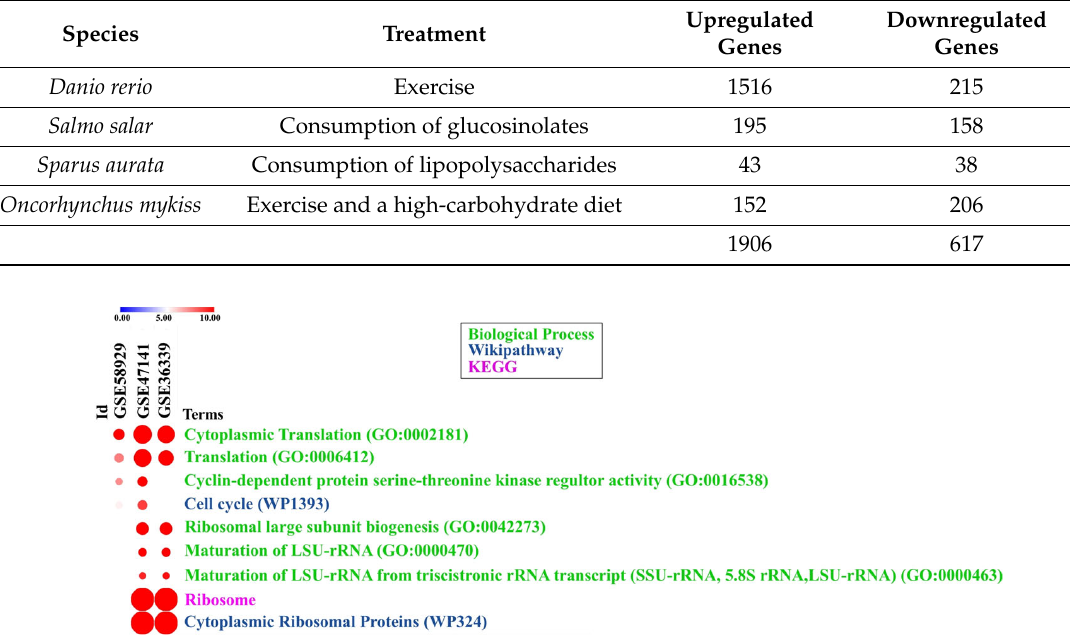
Figure 2. Biological processes and pathways associated with protein synthesis and